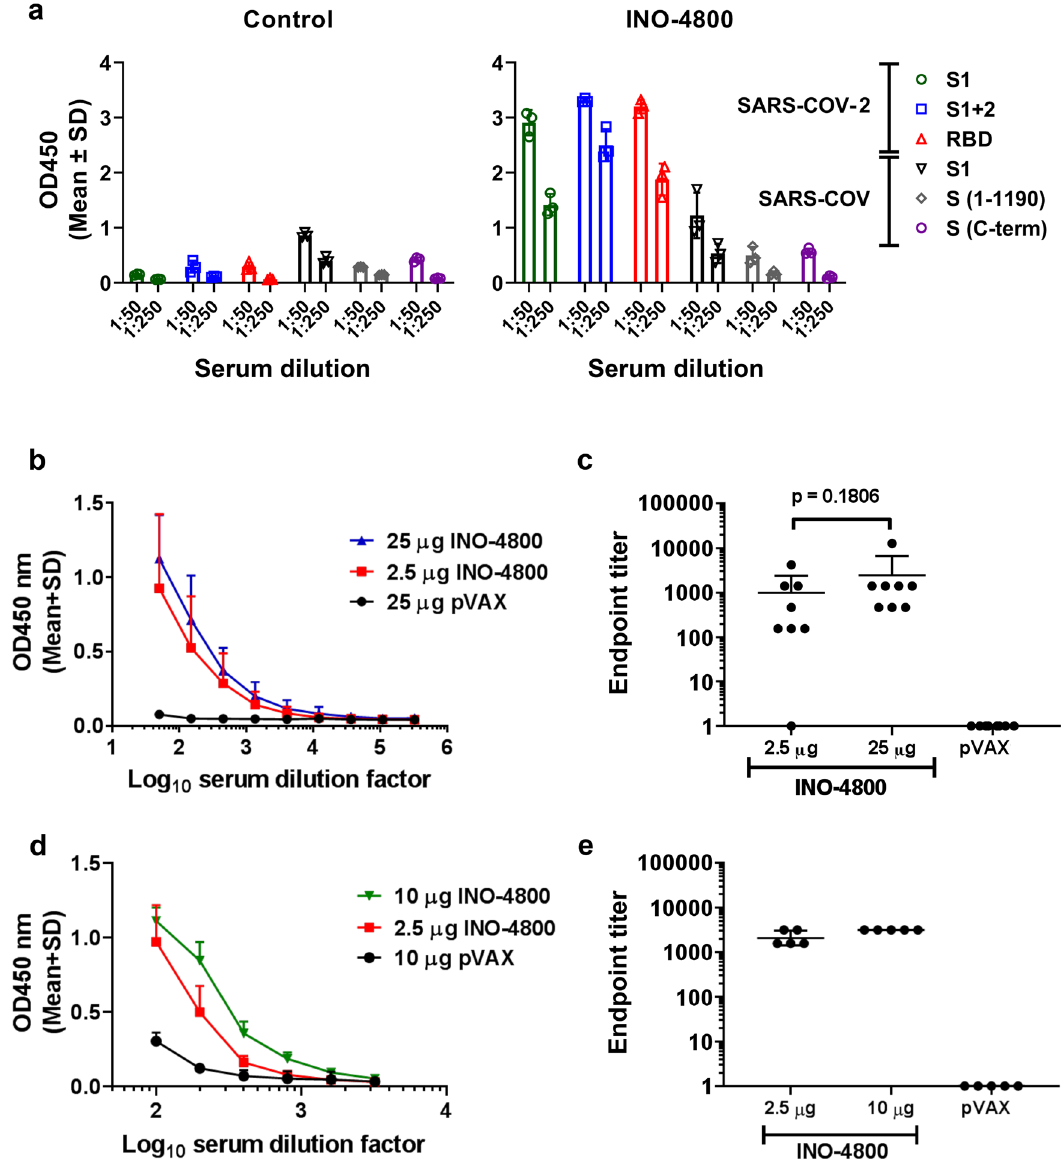
Fig. 3 Humoral responses to SARS-CoV-2 and SARS-CoV antigens in BALB/c mice after a single dose of INO-4800. BALB/c mice were immunized on day 0 with indicated doses of INO-4800 or pVAX-empty vector as described in the methods. a Protein antigen binding of IgG at 1:50 and 1:250 serum dilutions from mice at day 14 immunized with 25 µ g of INO-4800 or pVAX. Data shown represent mean OD450 nm values (mean + SD) for each group of 3 mice. b SARS-CoV-2 S1 + 2 or c SARS-CoV-2 RBD protein antigen binding of IgG in serial serum dilutions from mice at day 14. Data shown represent mean OD450 nm values (mean + SD) for each group of eight mice ( b , c ) and fi ve mice ( d , e ). Serum IgG binding endpoint titers to ( c ) SARS-CoV-2 S1 + 2 and ( e ) SARS- CoV-2 RBD protein. Data representative of two independent experiments. Values depicted are mean + / − SD. P values determined by Mann – Whitney